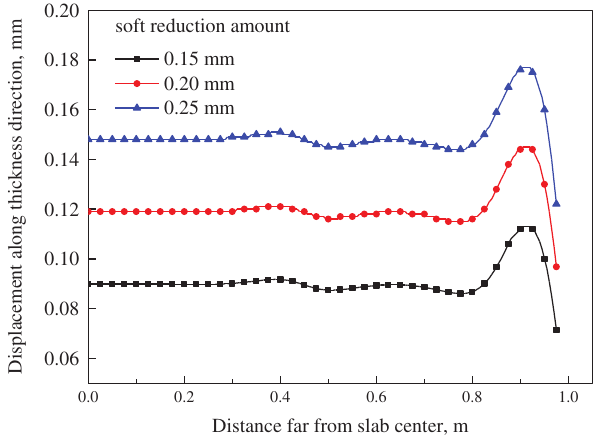
Figure 5: Relationship between displacement along thickness direction of slab and distance far from